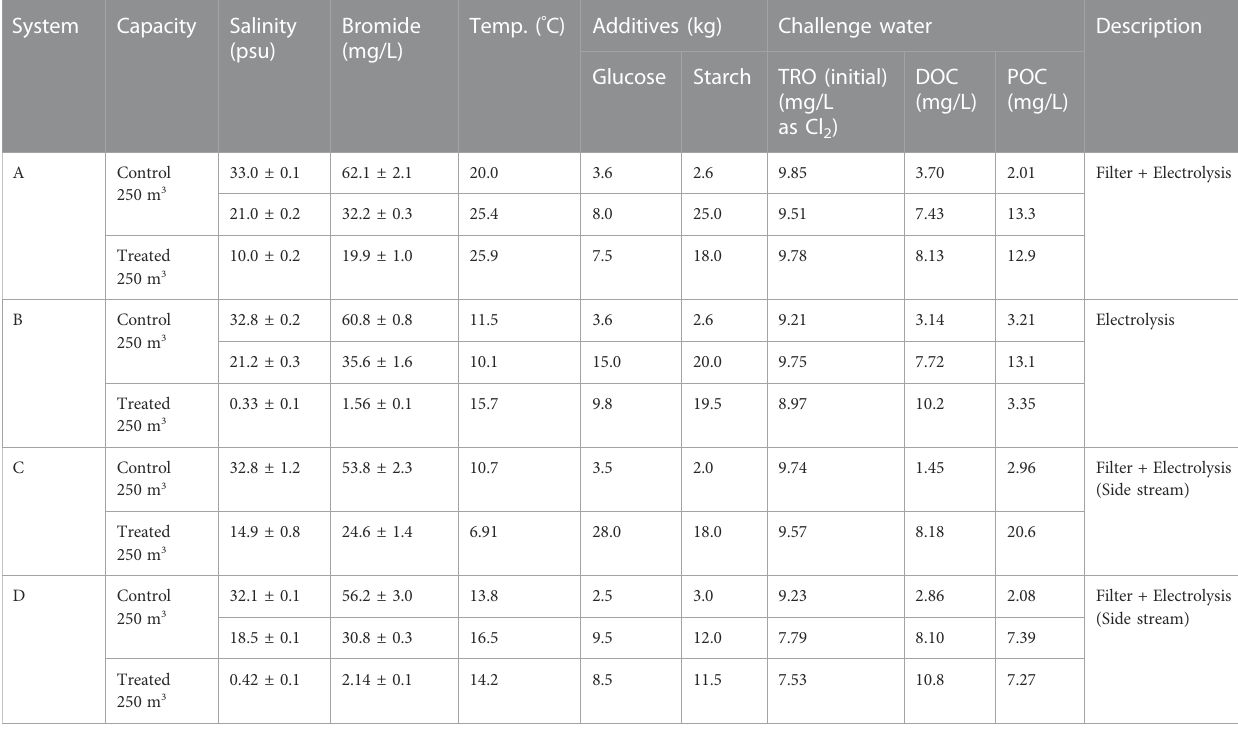
TABLE 1 Speci fi c parameters of challenge water and detailed information on the conducted land-based tests.